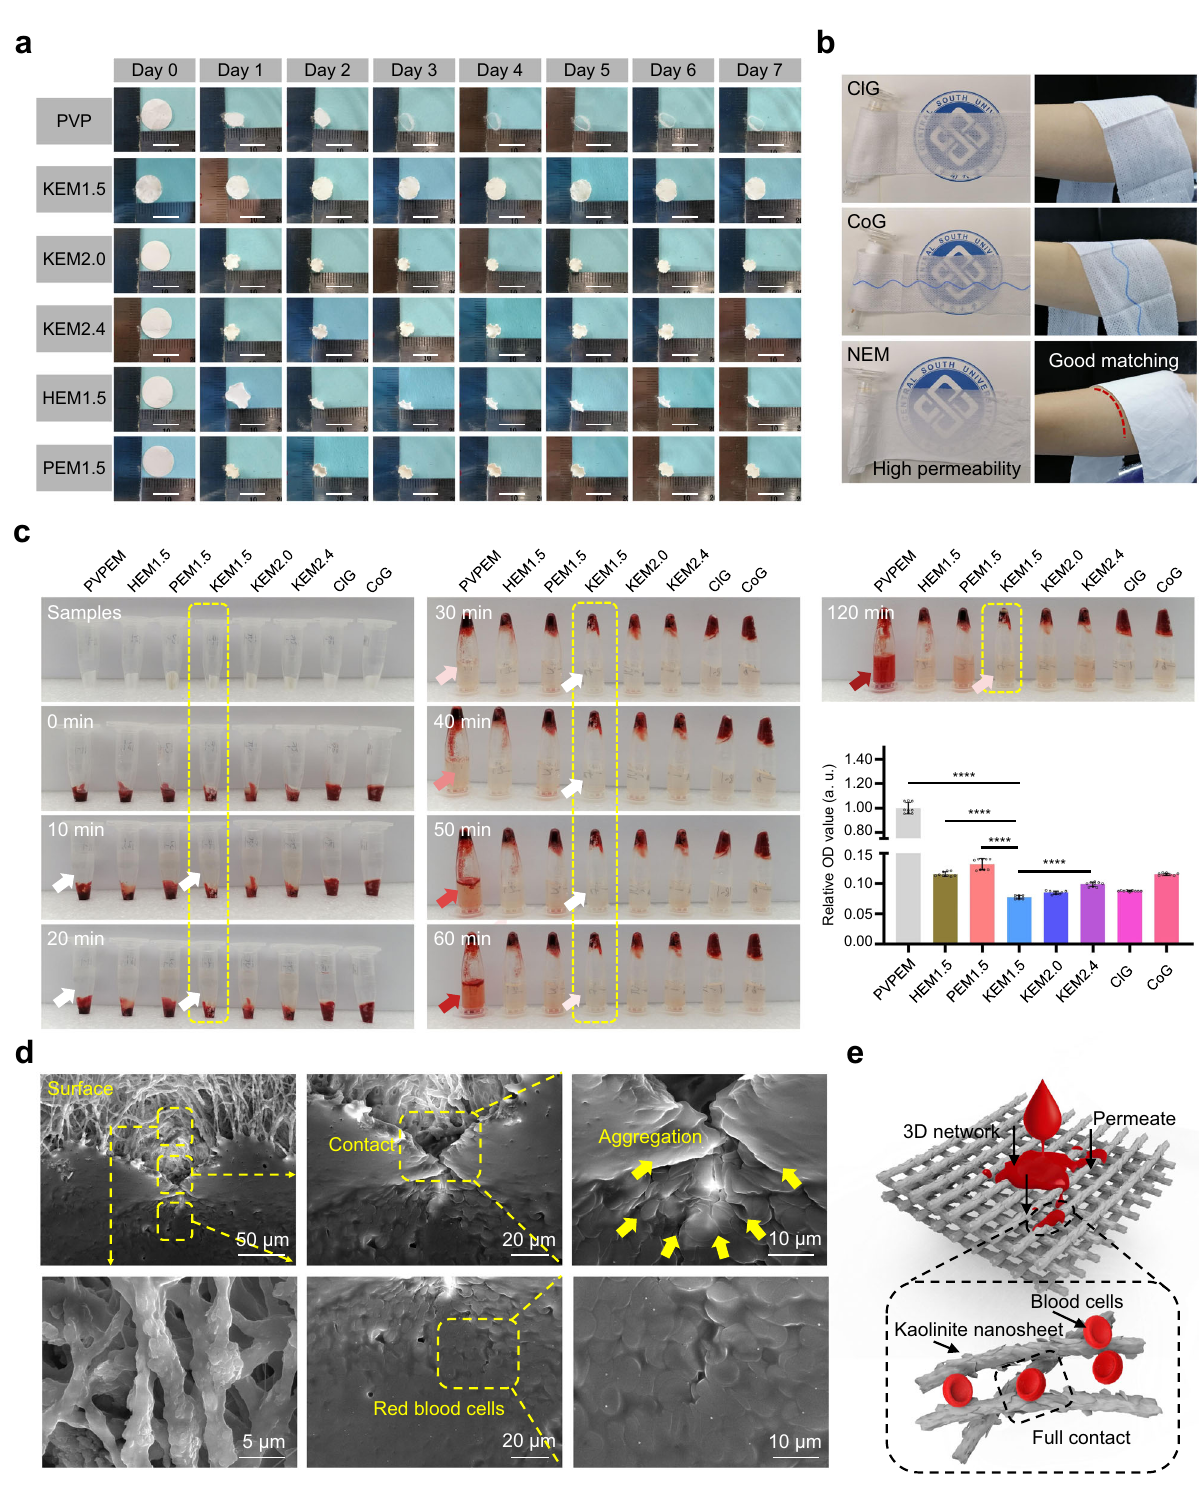
Fig. 3 Shrinkage and coagulation properties of nanoclay electrospun membranes in vitro. a Sample 7-day shrinkage tests and results under the condition of constant temperature and humidity for PVPEM, PEM 1.5 , HEM 1.5 , KEM 1.5 , KEM 2.0 and KEM 2.4 , respectively. Scale bar, 1 cm. b Photographs of the KEM 1.5 , ClG and CoG samples for the permeability and application on the skin. c Photographs from the in vitro blood-clotting measurement and the corresponding relative OD values of the supernatant absorbance for PVPEM ( n = 9), HEM1.5 ( n = 9), PEM1.5 ( n = 9), KEM 1.5 ( n = 9), KEM2.0 ( n = 9), KEM2.4 ( n = 9), ClG ( n = 9), CoG ( n = 9), respectively. Data were expressed as mean ± s.d.; (cid:1)(cid:1)(cid:1)(cid:1) , p < 0.0001. Student ’ s t test (two-sided) was used for statistical analysis of between two groups comparison in ( c ). d The SEM images of blood cells on the KEM 1.5 surface. Data were analyzed from at least three independently experiments in ( d ). e Illustration of blood components permeation and contact to the KEM1.5. All experiments were replicated at least three times independently with similar results. Source data are provided as a Source Data fi